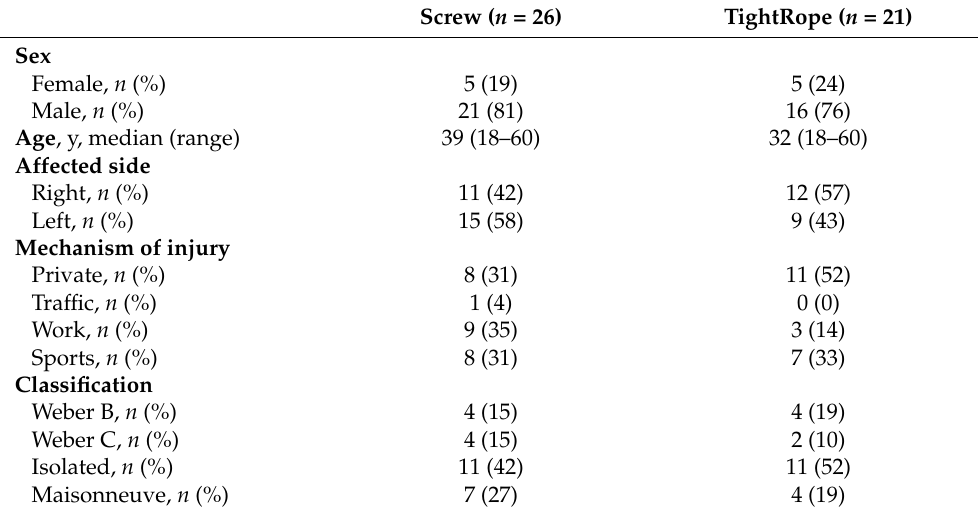
Table 1. Patient demographics and injury